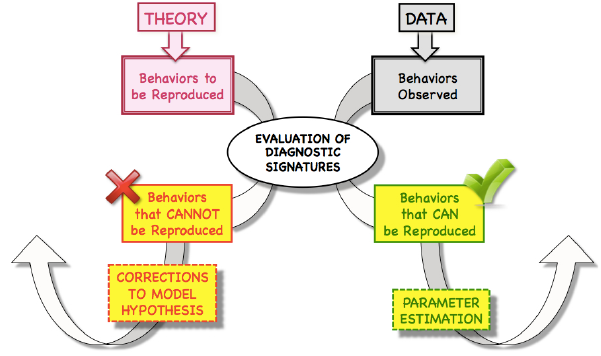
Fig. 1. How an approach based in evaluation of signature properties can be used to detect and diagnose model deficiencies and develop appropriate ways to improve the model/hypothesis (figure based on ideas presented in Gupta et al.,